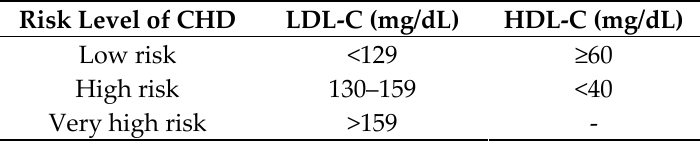
Table 1. Clinical concentration ranges of lipoproteins.